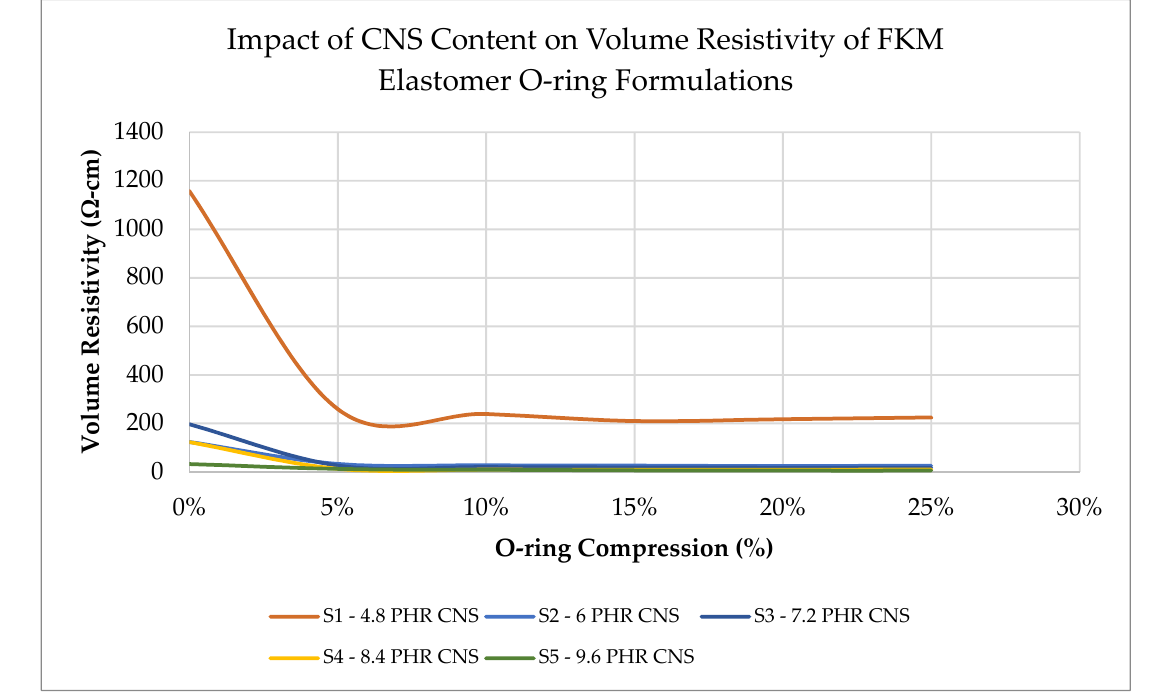
Figure 2. Effect of CNS content in the range of 4.8 to 9.6 PHR within elastomer O-rings on volume resistivity across multiple compression levels.